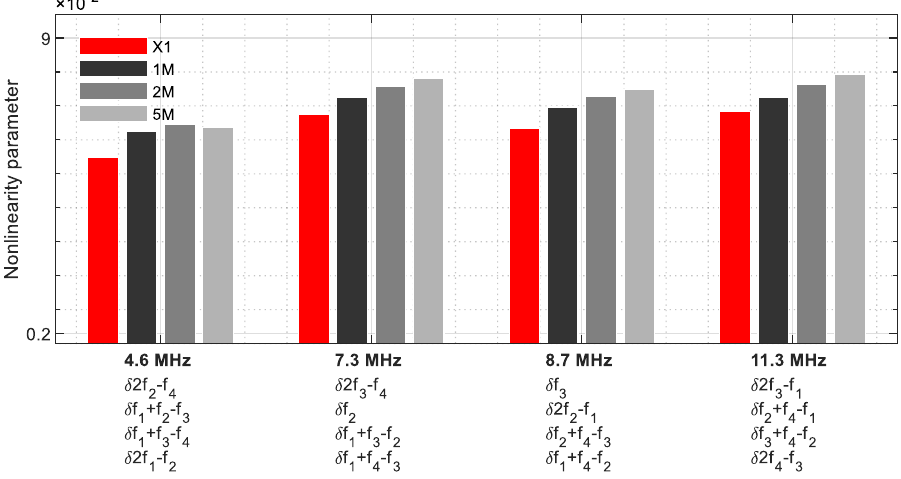
Figure 24. Nonlinearity parameter — δ G4 .